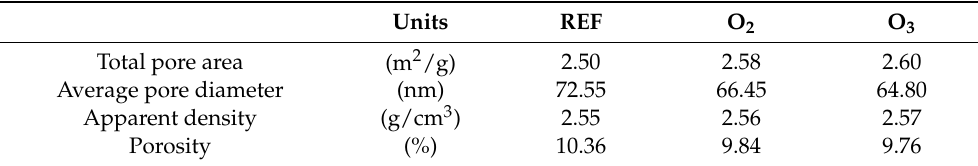
Figure 13. Pore size distribution of the concrete specimens with water comprising micro-nano oxygen bubbles (O 3 ) compared to the reference samples (REF). Table 8. Parameters of the microstructure of the cement paste determined by MIP.